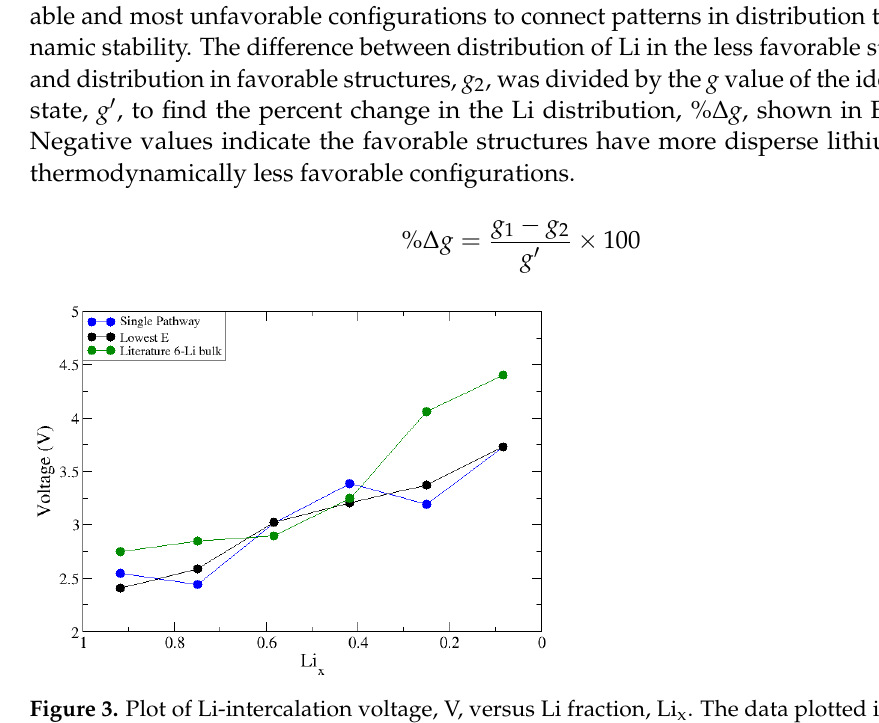
Figure 3. Plot of Li-intercalation voltage, V, versus Li fraction, Li x . The data plotted in blue follow approach 1 (single pathway), defined in the text. In black are the voltage values using lowest E configurations across Li x . The data plotted in green represent the literature results for a 6 Li atom bulk cell [1].